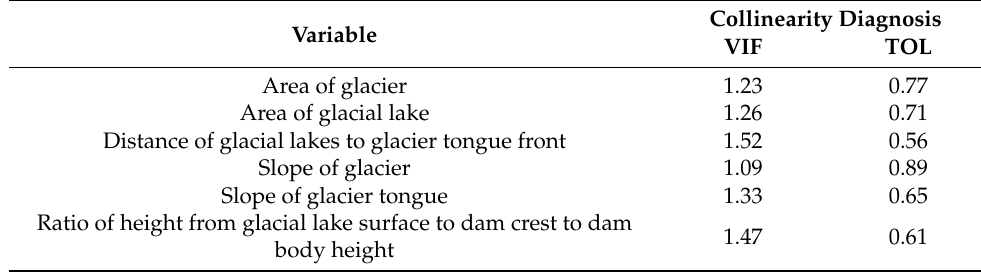
Collinearity Diagnosis VIF TOL